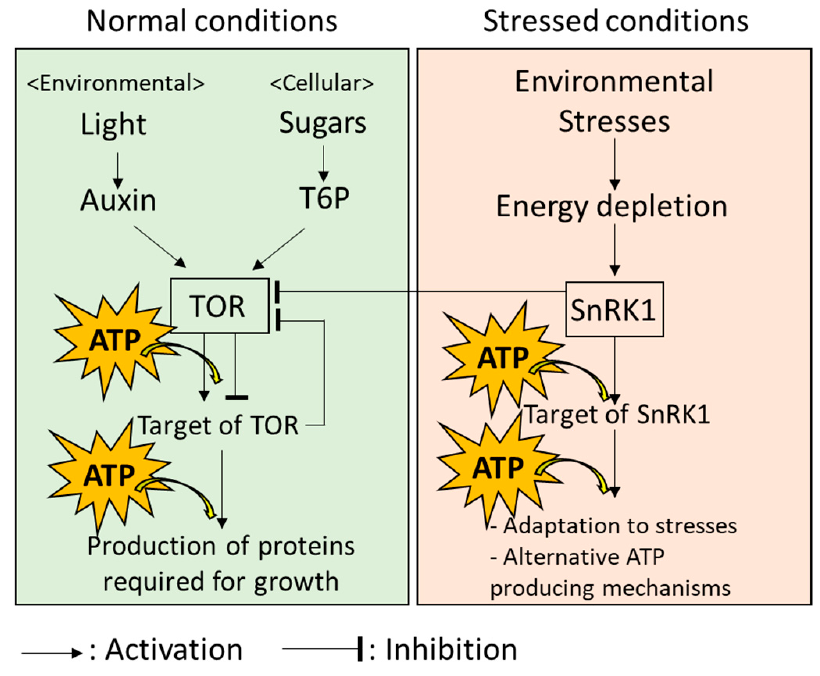
Figure 2. Energy-modulation systems in plant cells involving TOR and SnRK1.